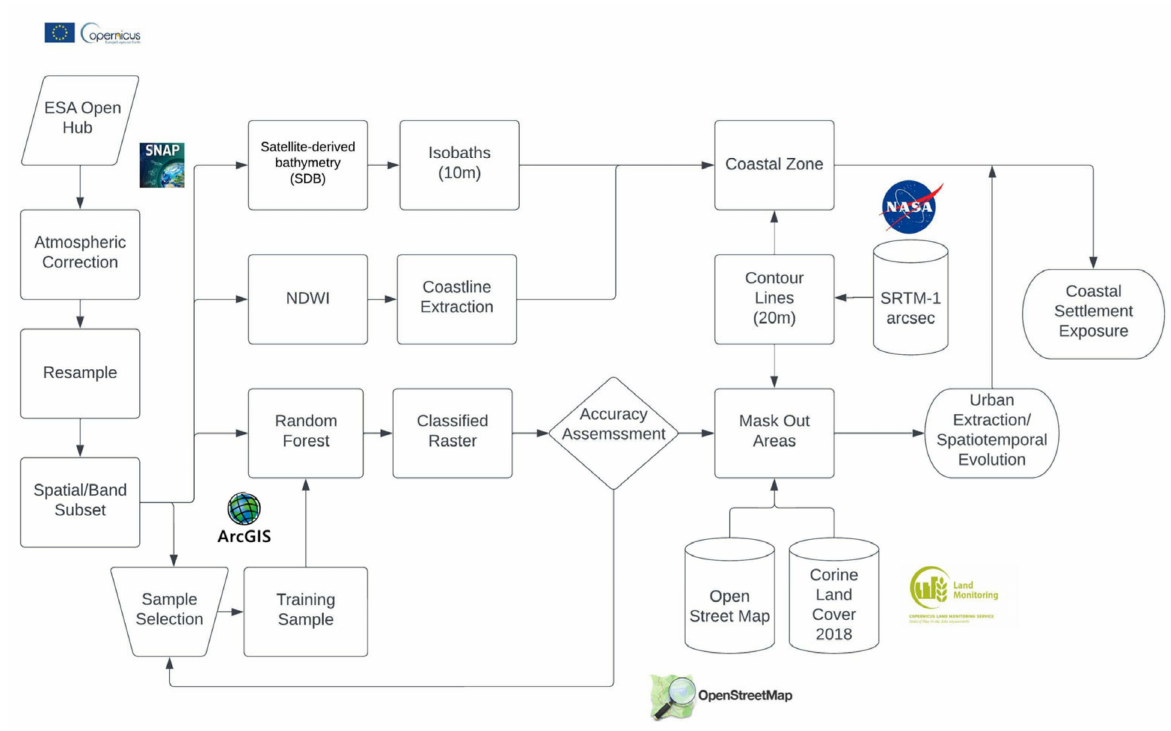
Figure 4. Workflow of the satellite and geospatial datasets that were implemented for the three-fold process adopting GEOINT and